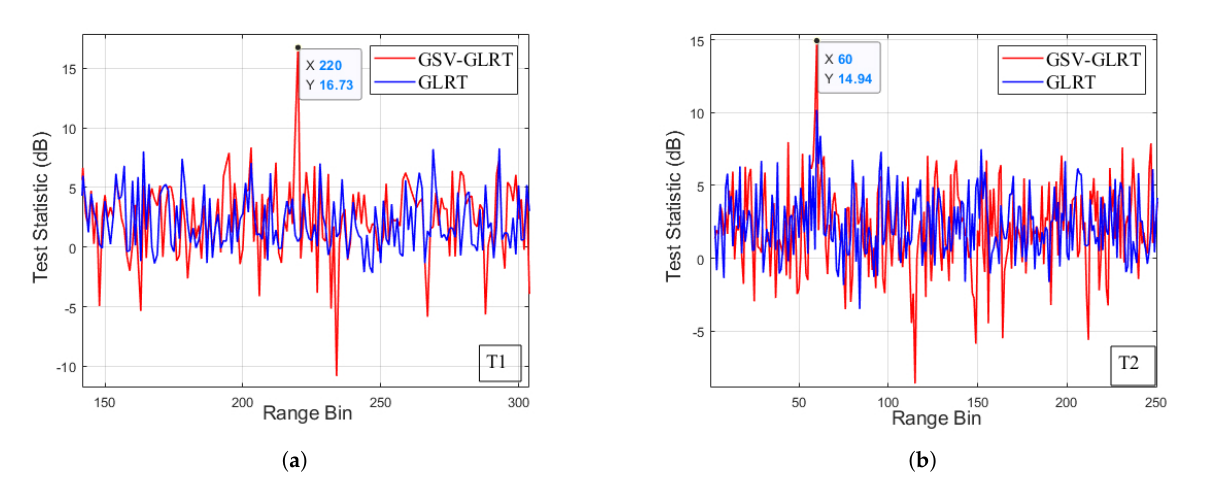
Figure 8. Detection results of the detectors ( a ) test statistic of target T1 in R = 220 ( b ) test statistic of target T2 in R =